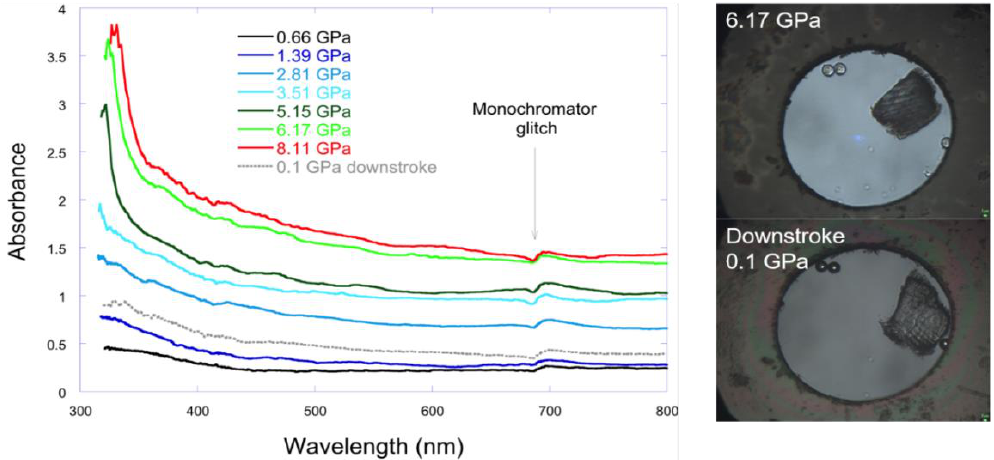
Figure 10. On the left: UV-Vis absorption spectra of 4-iodobenzonitrile as a function of pressure. On the right: images of the hydrostatic chamber with the sample and ruby spheres. The crystal does not completely recover its integrity after pressure release.